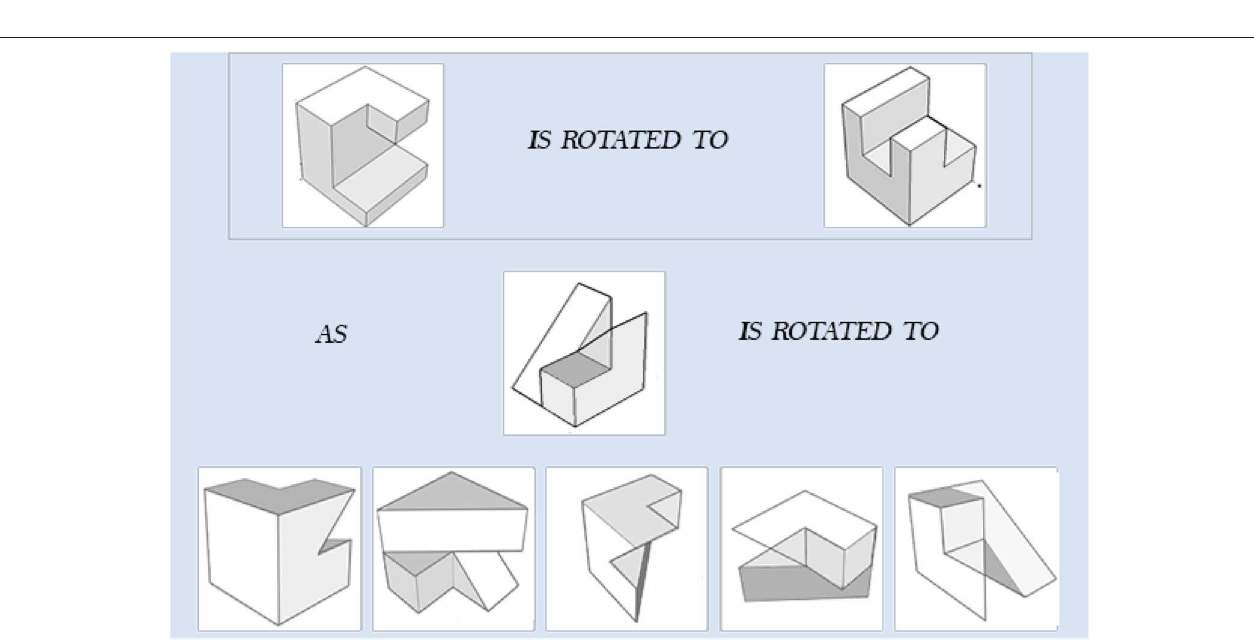
FIGURE 10 | The item (ID:30) with the largest slipping parameter s